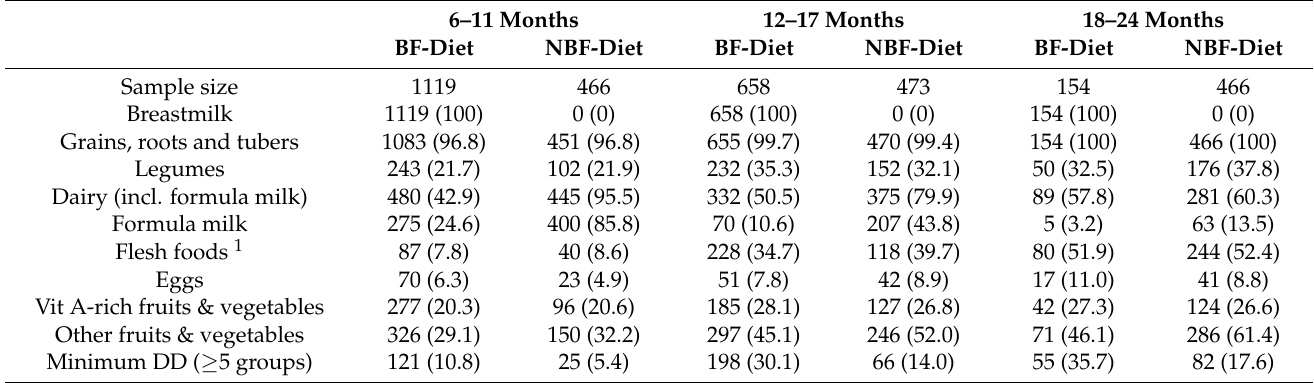
Figure 1. Box plots for the retail cost values per age group and diet type. BF, breastfed; m, months; NBF, non-breastfed. Table 2. Food groups included in BF and NBF diets for the three age categories, n